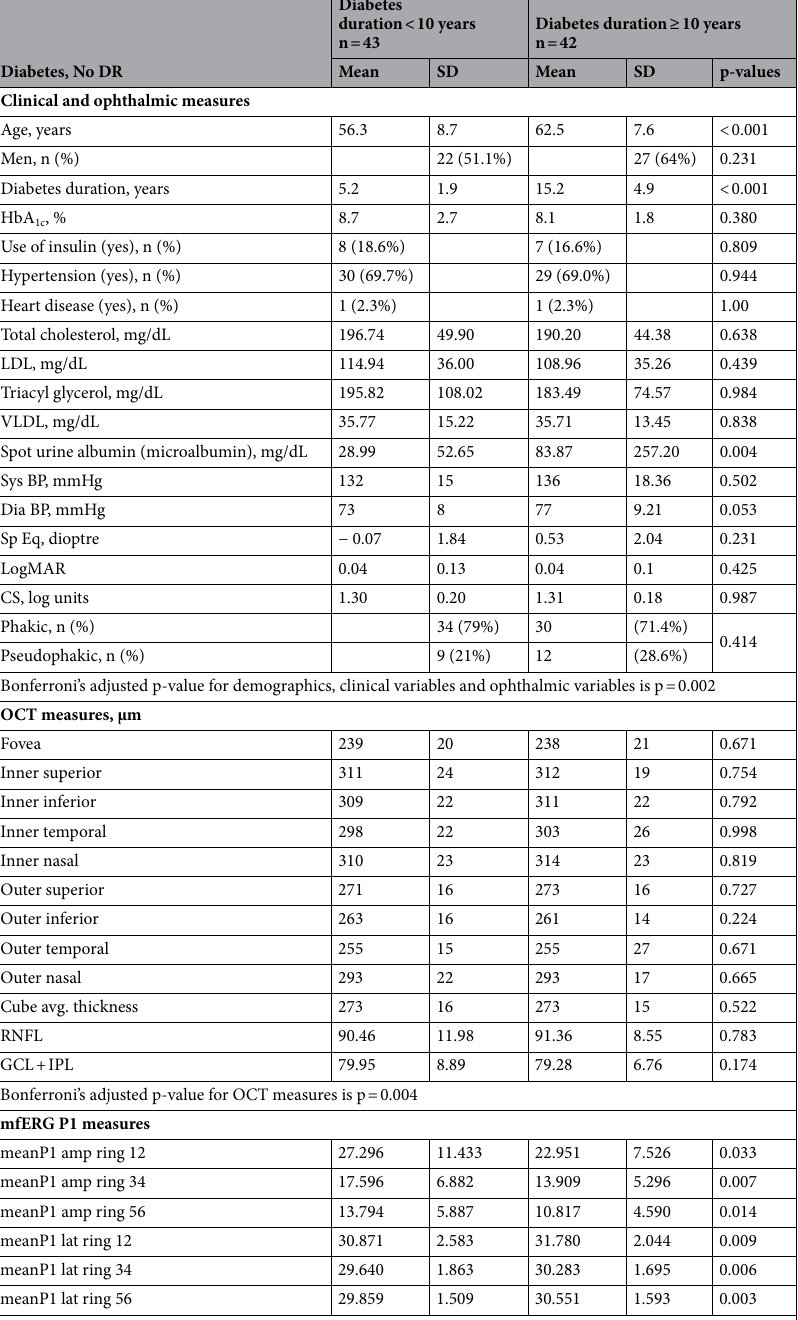
Table 1. Clinical, optical, OCT and mfERG measures stratified according to diabetes duration. DR diabetic retinopathy, BP blood pressure, Sp Eq spherical equivalent, LogMAR Logarithm of the minimum angle of resolution, CS contrast sensitivity, RNFL retinal nerve fibre layer, GCL + IPL ganglion cell layer + inner plexiform layer, Lat Latencies expressed as milliseconds, amp amplitude assessed as response density, nV/deg 2